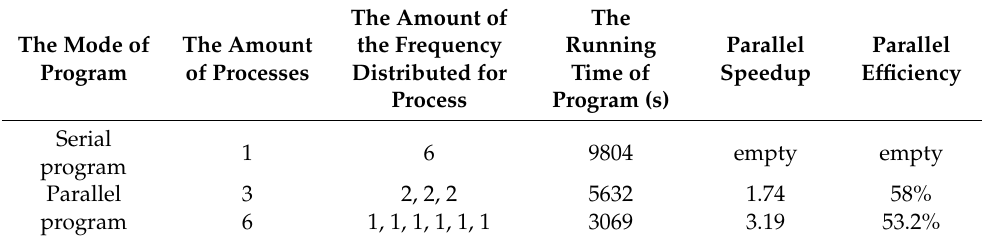
Table 3. The statistics of the time for the algorithm.